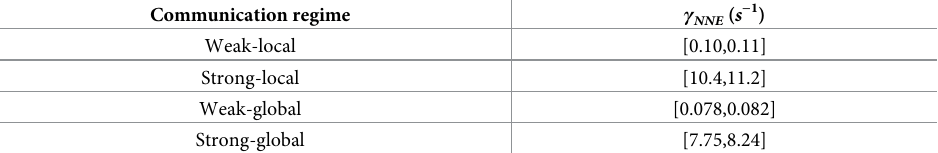
Table 2. Exchange rates in the NNE model for the comparison with the ISD model. Range of values of γ NNE employed for the comparisons of communication models in each regime of the ISD model. We considered 10 sets of configurations with 127 cells and different values of the mean polygon number (data shown in Fig 7).